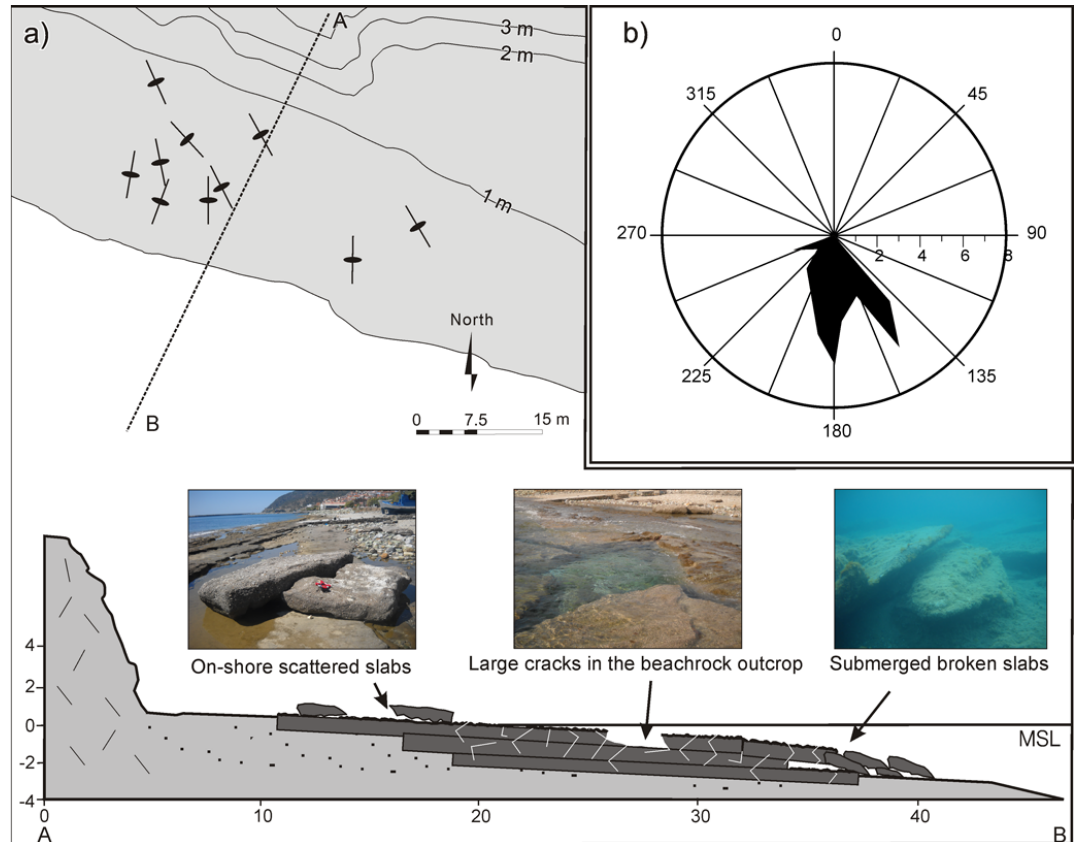
Fig. 3. (a) A-axis orientation and schematic sketch of deposition pattern of a cluster of boulder in Plomari: elevation and distance are expressed in meters. (b) Frequency of a-axis direction of the mapped